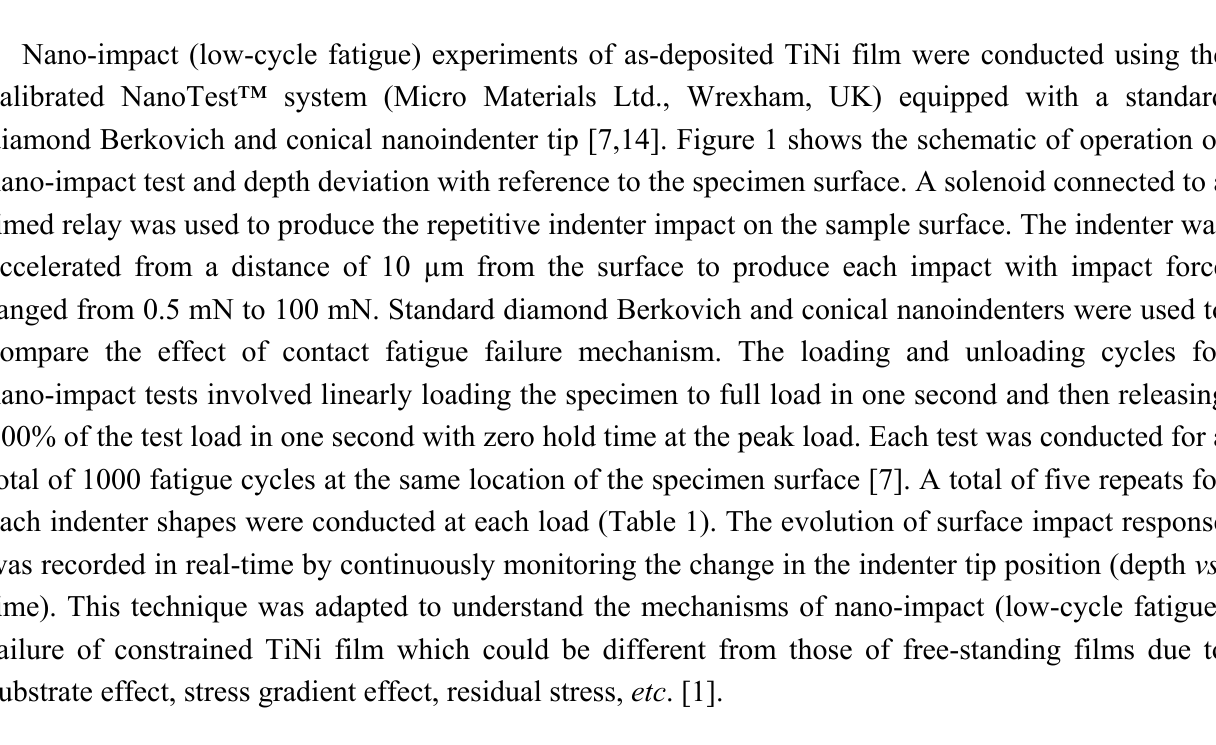
Figure 1. Schematic of operation of nano-impact test (NanoTest™) and depth deviation with reference to the specimen